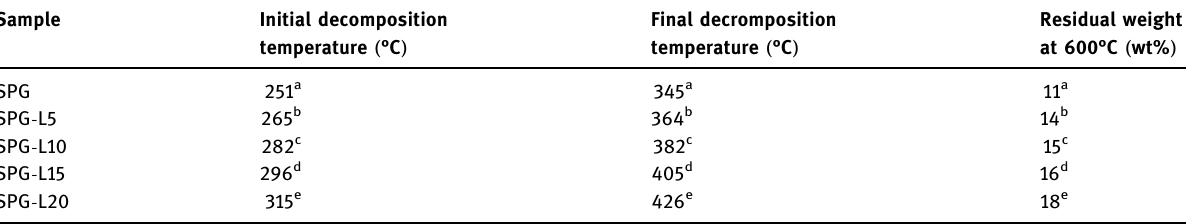
Table 1: Thermogravimetric analysis of blend fi lms